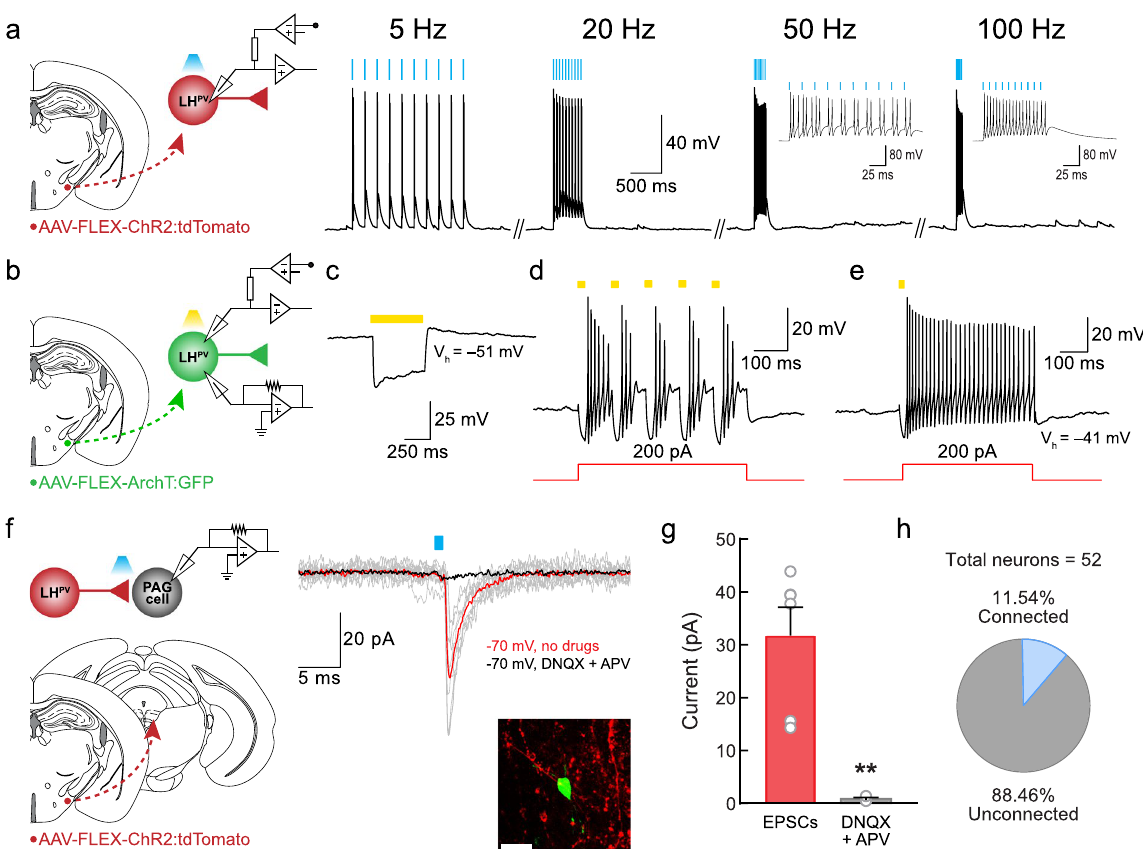
Figure 2. LH PV neurons provide excitatory input to neurons in the vlPAG. ( a ) ( Left Panel ) Schematic of whole- cell current-clamp recordings of ChR2-expressing LH PV neurons. ( Right Panels ) Representative traces from a ChR2-expressing LH PV neuron responding to photostimulation (470 nm light) at 5 Hz (100 ± 0% fidelity), 20 Hz (103 ± 9% fidelity), 50 Hz (83 ± 9% fidelity), and 100 Hz (75 ± 15% fidelity). ( Insets ) Expanded 50 Hz and 100 Hz traces. ( b ) Schematic of whole-cell current-clamp and voltage-clamp recordings of ArchT-expressing LH PV neurons. ( c ) Representative traces from an ArchT-expressing LH PV neuron responding to photoinhibition by a 500-ms yellow (590 nm) light pulse during a depolarizing current injection of 100 pA, ( d ) consecutive 20-ms light pulses delivered at 20 Hz during continuous depolarizing current injection of 200 pA, and ( e ) a single 20-ms light pulse delivered at the beginning of current injection. Note that a 500-ms light pulse evoked an inward hyperpolarizing current and both single and consecutive 20-ms light pulses blocked firing activity of LH PV -ArchT + neurons triggered by a depolarizing current injection. ( f ) ( Left Panel ) Schematic of ChR2-assisted circuit mapping for LH PV -ChR2 + axonal projections in the vlPAG. ( Middle Panel ) Representative traces of excitatory postsynaptic currents (EPSCs; gray) evoked by photostimulation (5-ms light pulses) of LH PV -ChR2 + axons in the vlPAG before (red trace) and after (black trace) bath application of DNQX and APV (AMPA-R and NMDA-R antagonists). Traces are the average of ten consecutive sweeps. ( Right Panel ) Recorded vlPAG neuron filled with biocytin (green) surrounded by ChR2:tdTomato-expressing LH PV axons (red). Scale bar: 20 μ m. Schematic images adapted from Franklin and Paxinos 38 . ( g ) Summary bar graph showing the amplitude of excitatory postsynaptic currents (EPSCs) evoked by photostimulation of LH PV -ChR2 + axons in the vlPAG before (EPSCs; red) and after (gray) bath application of 10 µ M DNQX and 50 µ M APV (AMPA-R and NMDA-R antagonists). Bars represent mean ± s.e.m.; circles indicate data from individual vlPAG neurons. ( h ) Summary chart showing the percentage of vlPAG neurons that exhibited a synaptic response during photostimulation of LH PV -ChR2 +